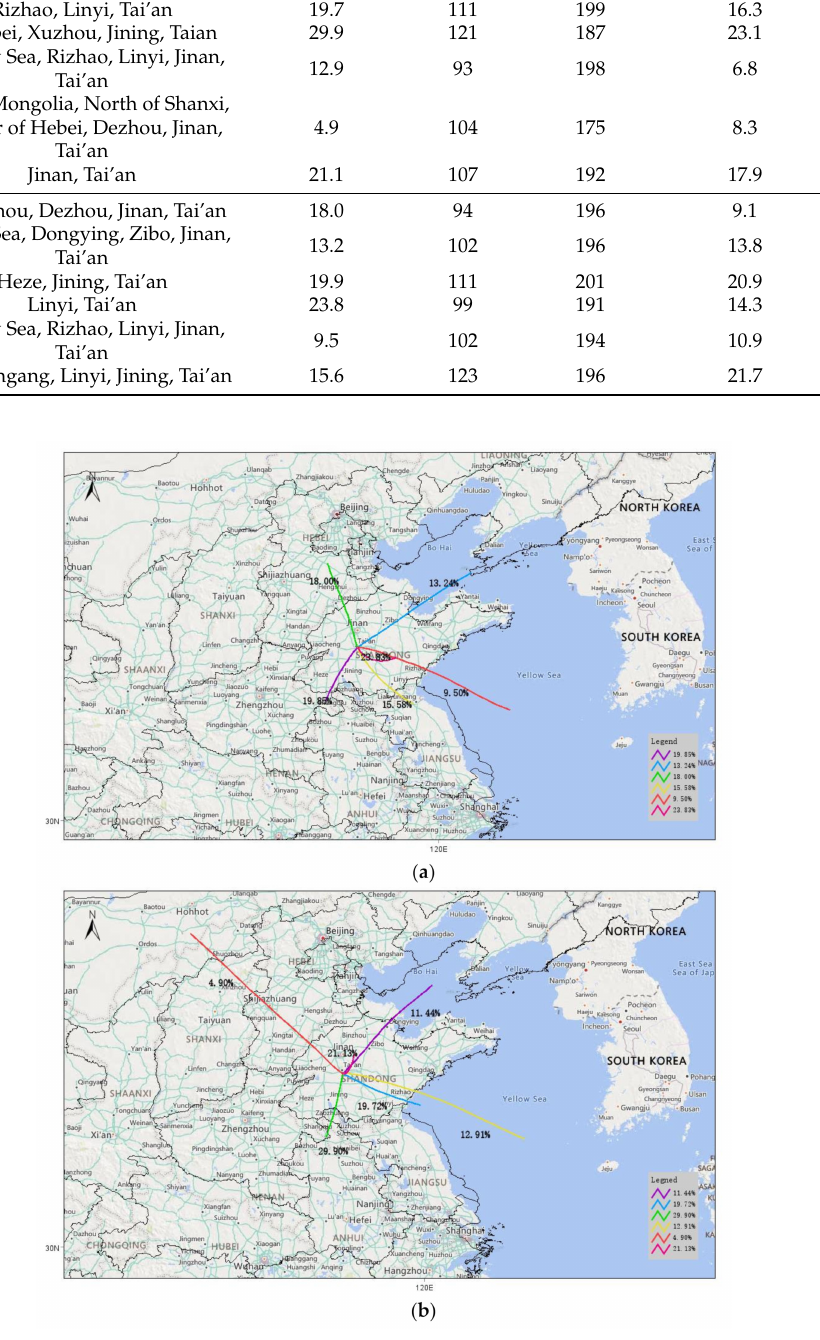
Figure 4. Clusters of average trajectory pathways of O 3 in Tai’an during May–September in 2020 ( a ) and 2021 ( b